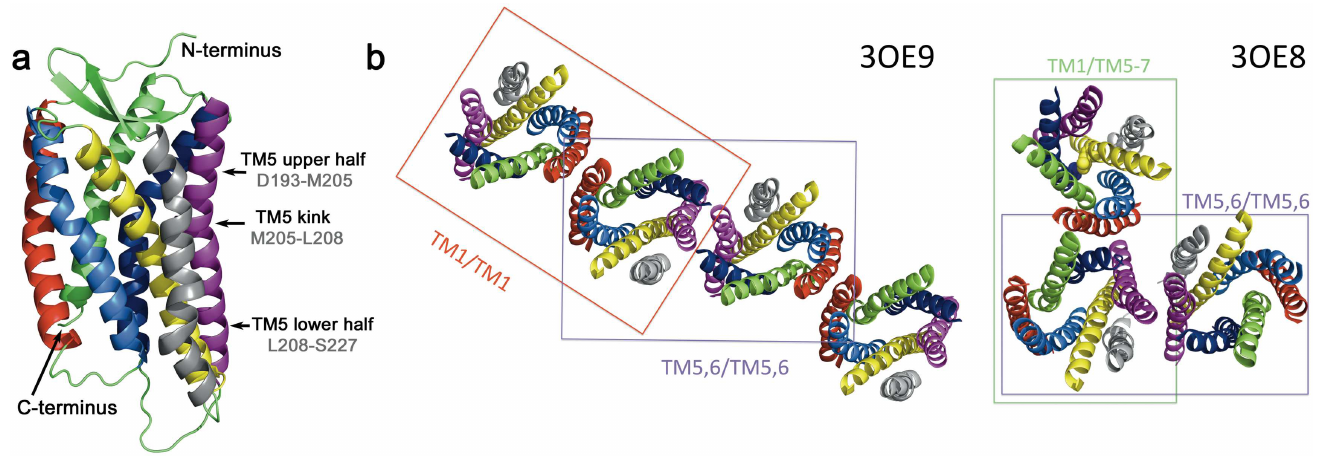
Fig 1. Crystal structures and dimers of CXCR4. ( a ) Structure of CXCR4 in cartoon representation. The coloring of the TM is as follows: TM1 is shown in red (Ala34-Gly64), TM2 in marine blue (Met72-Ala100), TM3 in yellow (Asn106-Val139), TM4 in grey (Gln145-Phe174), TM5 in magenta (Asp193-Ser227), TM6 in dark blue (Leu238-Leu267), and TM7 in green (Cys274-Leu301). ( b ) Dimerization interfaces as observed in crystal structures (pdb entries 3OE9 and 3OE8 [17]).